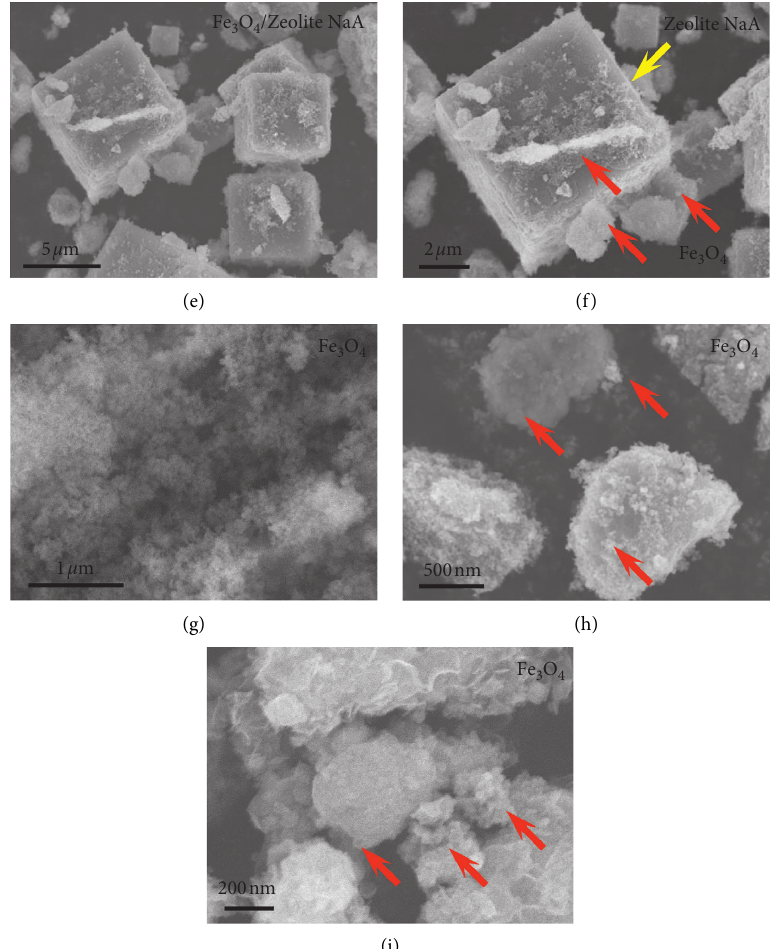
Figure 4: FESEM images of the as-synthesized zeolite A (a–c), 3.3% Fe